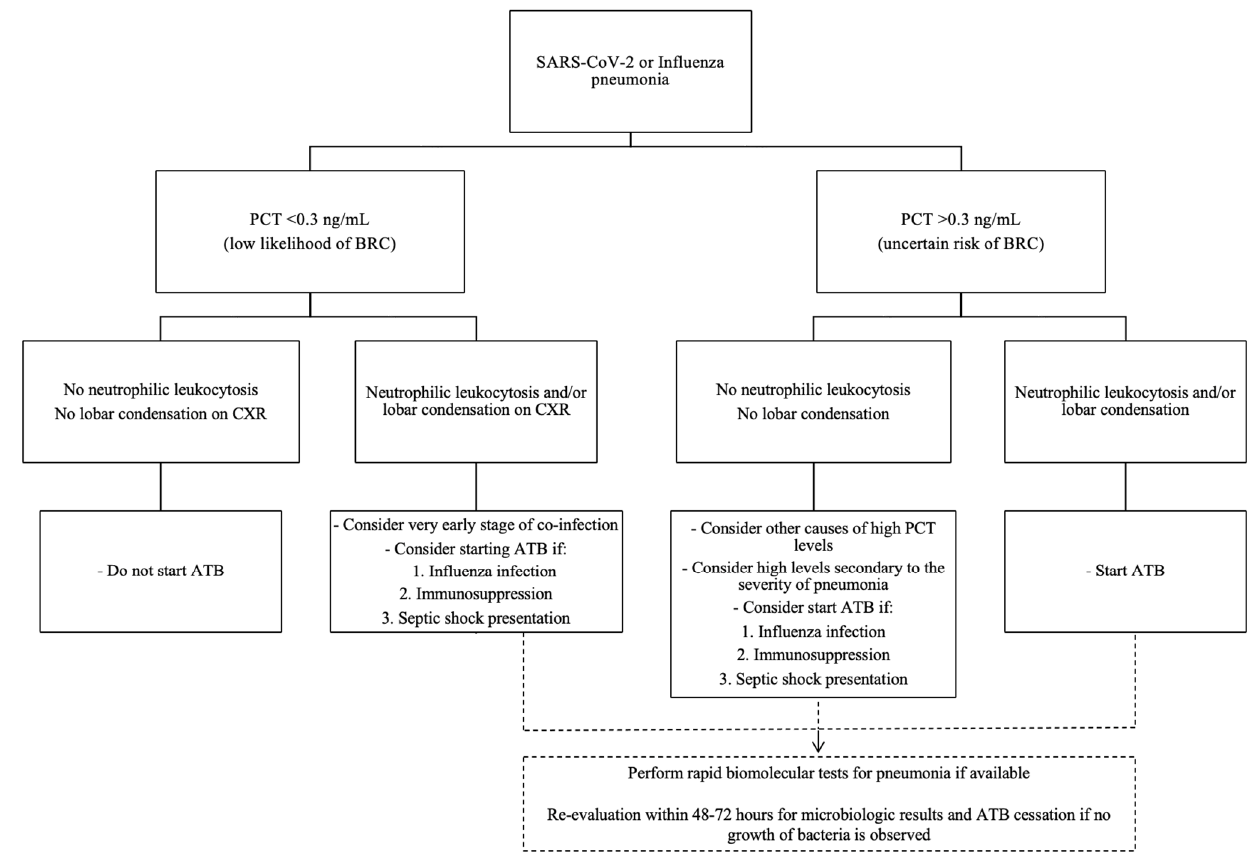
Figure 1. Procalcitonin-based algorithm for the decision to initiate, continue or stop antibiotics for patients with Influenza or SARS-CoV-2 pneumonia. Abbreviations: PCT: procalcitonin; BRC: bacterial respiratory co-infection; CXR: chest X ray; ATB: antibiotic.